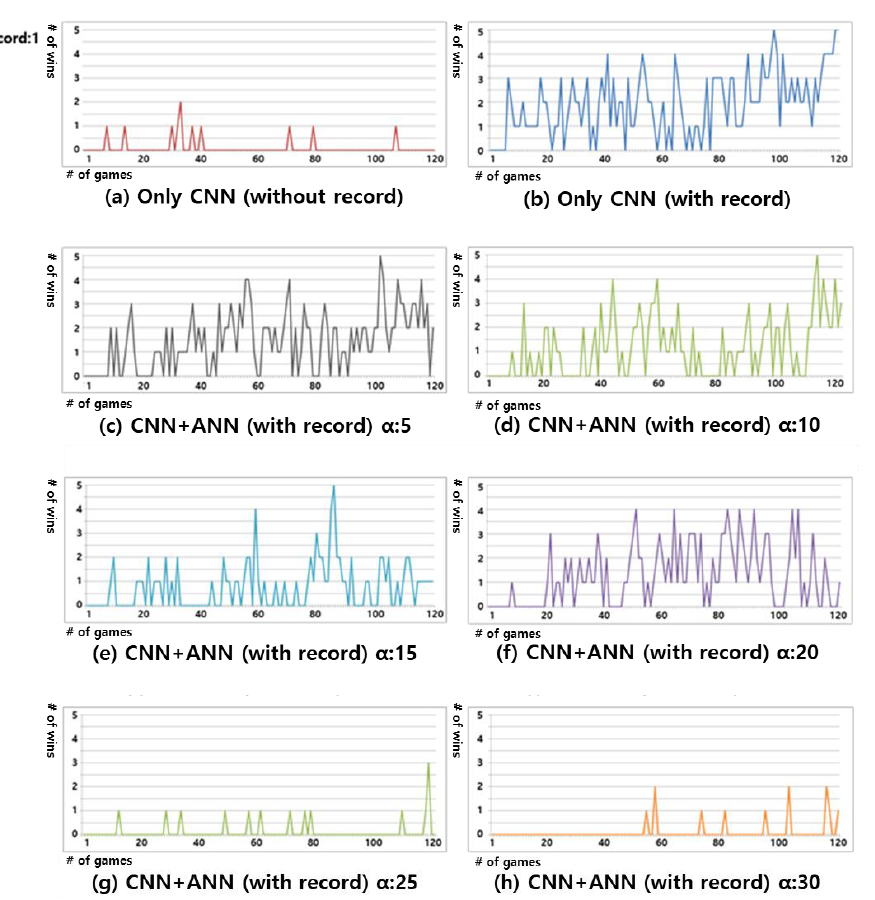
Figure 9. Result of Win rate when Record count was one. Each graph y-axis refers to the number of wins from 0 to 5, and the x-axis refers to the number of games from 0 to 120. The figures show the experimental result using: ( a ) only CNN without Record relearning; ( b ) CNN with Record relearning without ANN; ( c ) Proposed Gomoku system with ANN α :5; ( d ) Proposed Gomoku system with ANN α :10; ( e ) Proposed Gomoku system with ANN α :15; ( f ) Proposed Gomoku system with ANN α :20; ( g ) Proposed Gomoku system with ANN α :25; and, ( h ) Proposed Gomoku system with ANN α :30.